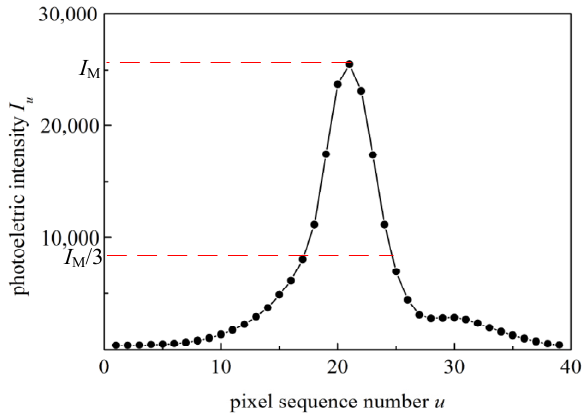
Figure 4. The photoelectric intensity distribution curve.